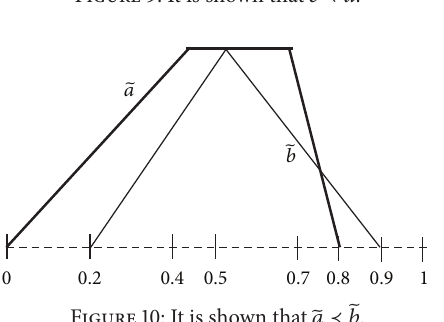
Figure 9: It is shown that ̃𝑐 ≺ ̃𝑎 .